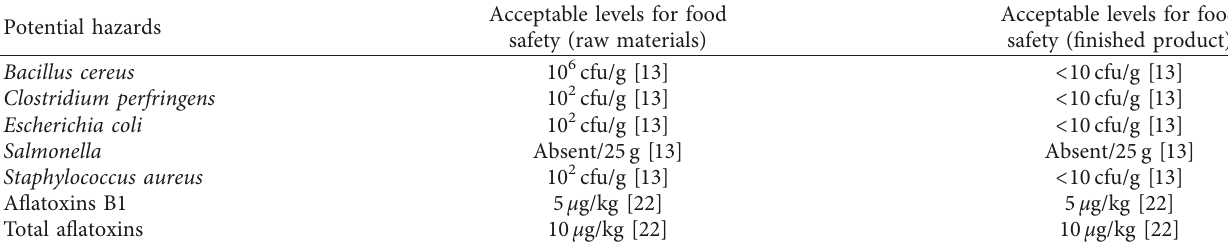
Table 1: Acceptable levels of identified potential hazards for food safety.